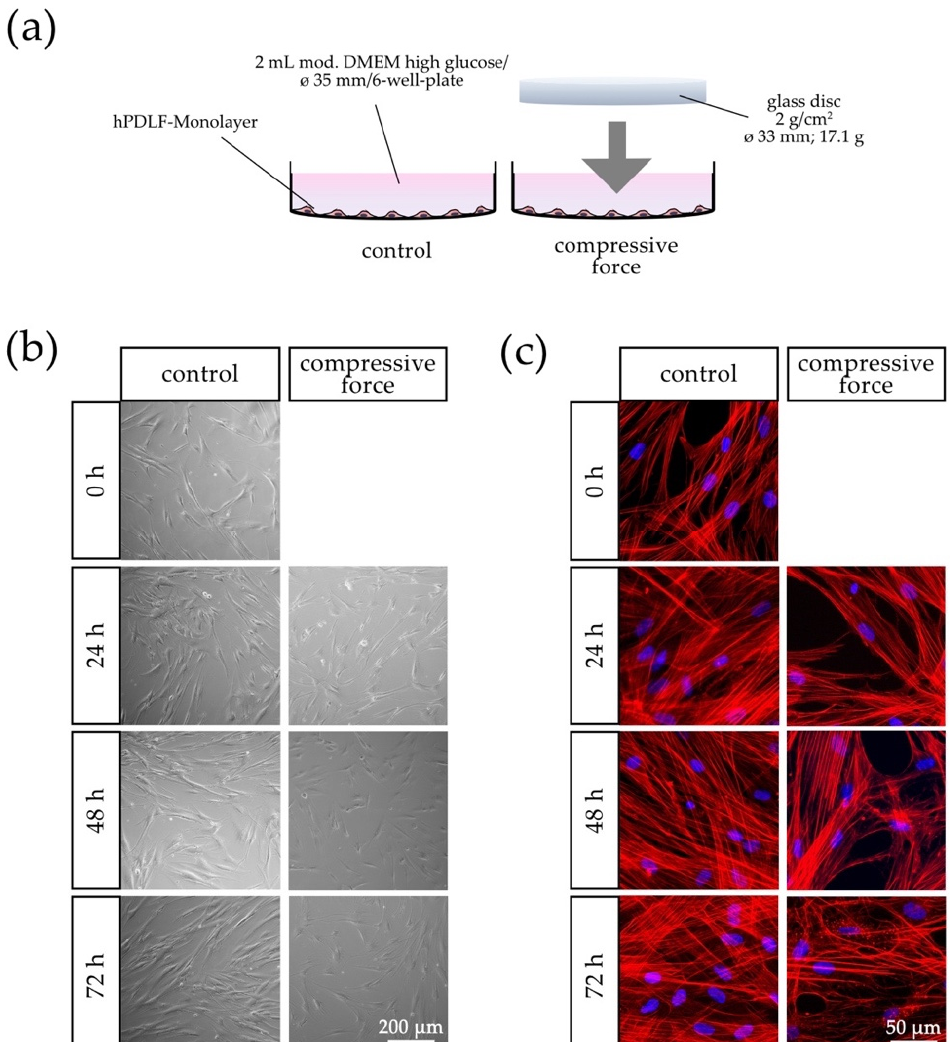
Figure 1. Effects of compressive force (CF) on hPDLFs in terms of confluence and morphology compared to the control group at 0–72 h. ( a ) Schematic representation of the CF in vitro model with a sterile glass cylinder placed on the monolayer. ( b ) Light microscopic and ( c ) fluorescence microscopic phalloidin/DAPI photographs. In addition to the confluence reduction at each time point, morphological changes were especially evident after 72 h in the CF group due to the disorganization of actin filaments and punctuate accumulation of